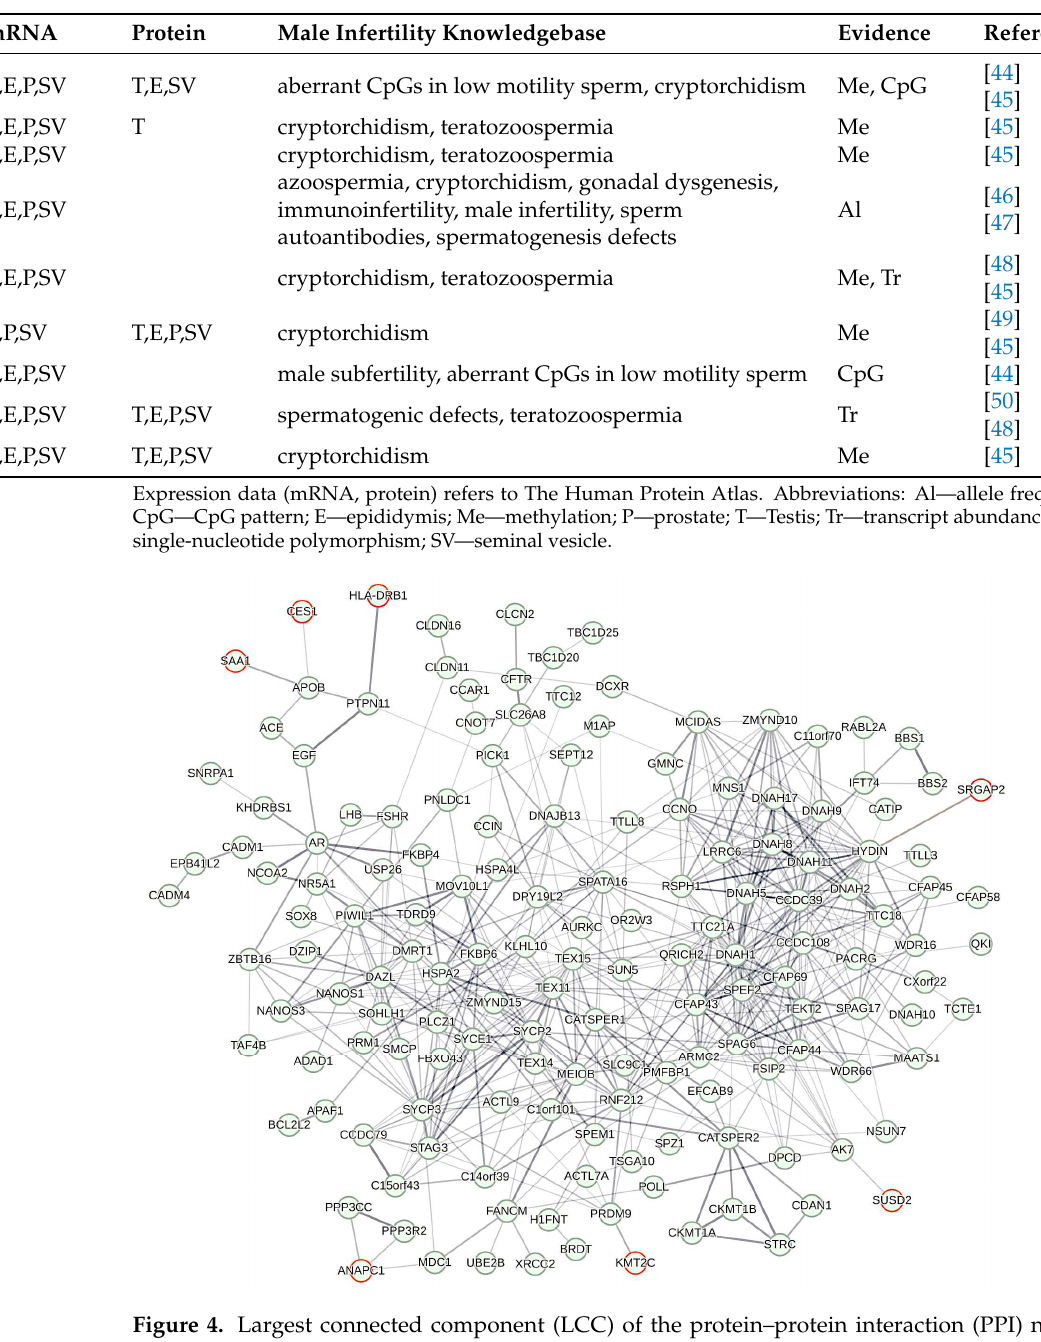
Figure 4. Largest connected component (LCC) of the protein–protein interaction (PPI) network re- constructed from genes implicated in male infertility. Most of the proteins included refer to genes reported in NCBI OMIM for their involvement in male infertility. Proteins to seven out of nine genes emerging from present GWAS (red circles) are included in the LCC, thereby occupying peripheral positions. Correspondingly, the number of PPIs per each of these genes is 1.286, whereas average node degree is 3.628 across the entire LCC. The LCC has 166 nodes between which 566 PPIs extend. Compared to the expected number of edges (N = 79) this represents a highly significant enrichment ( p < 1 × 10 −16 ). Average clustering coefficient across the LCC is 0.518. Strength of edges gives incre- ments of minimum confidence (0.150, 0.400, 0.700, 0.900). Network reconstruction was conducted with STRING v11.5 using standard